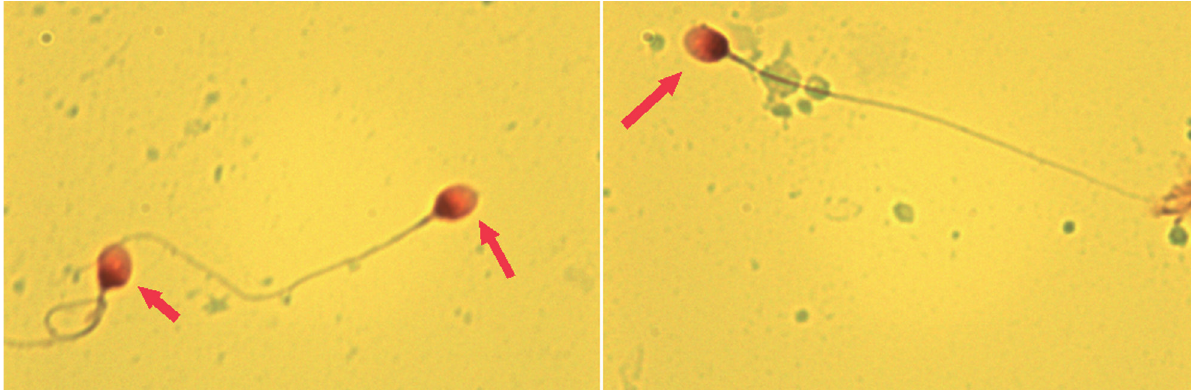
Figure 1 - Spermatozoa found after microcentrifugation technique (2000g for 15 minutes), stained by nuclear fast red and picroindigocarmine (described as NF-PICS or Christmas Tree stain) in an azoospermic man. We observed clear slides obtained with sperm integrity preserved, without cellular